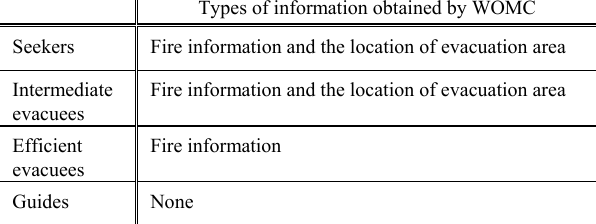
Table 4. Contents of information obtained by